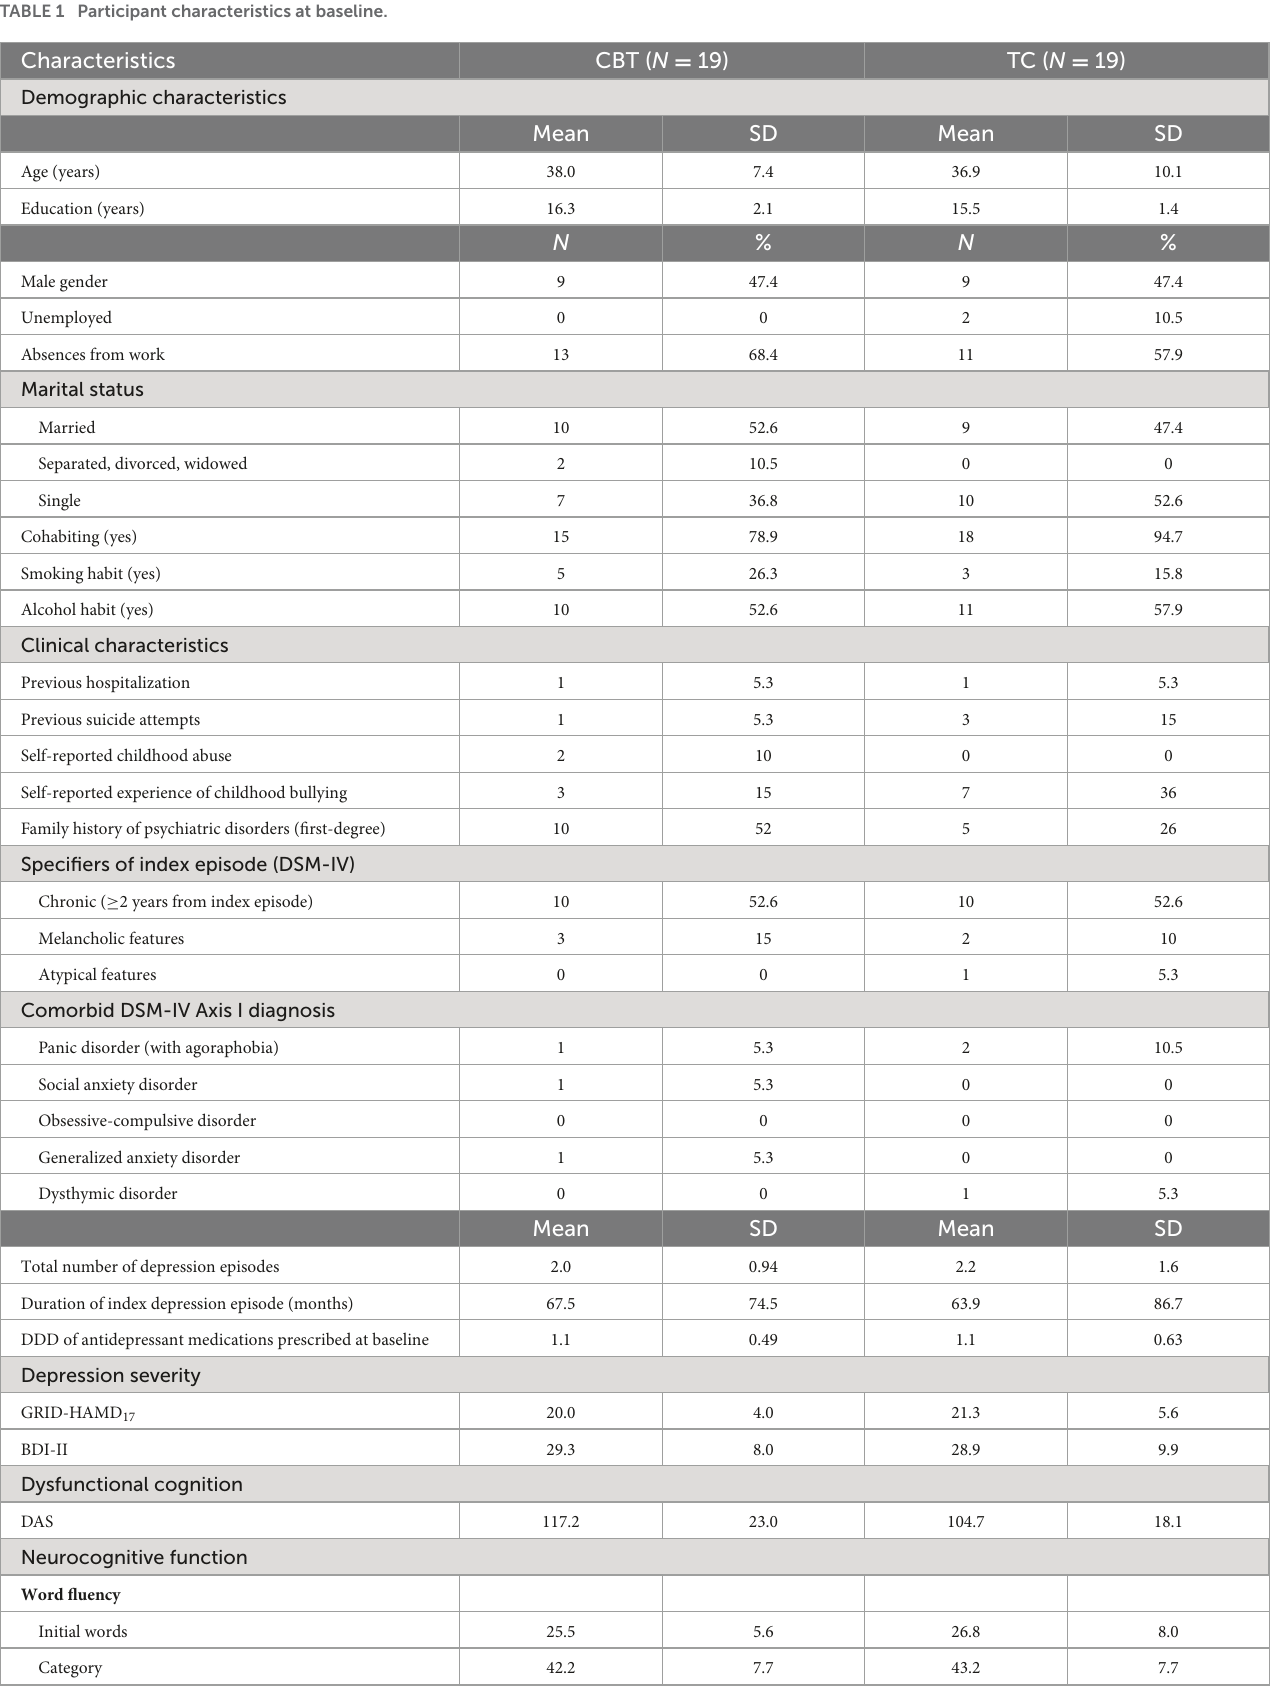
TABLE 1 Participant characteristics at